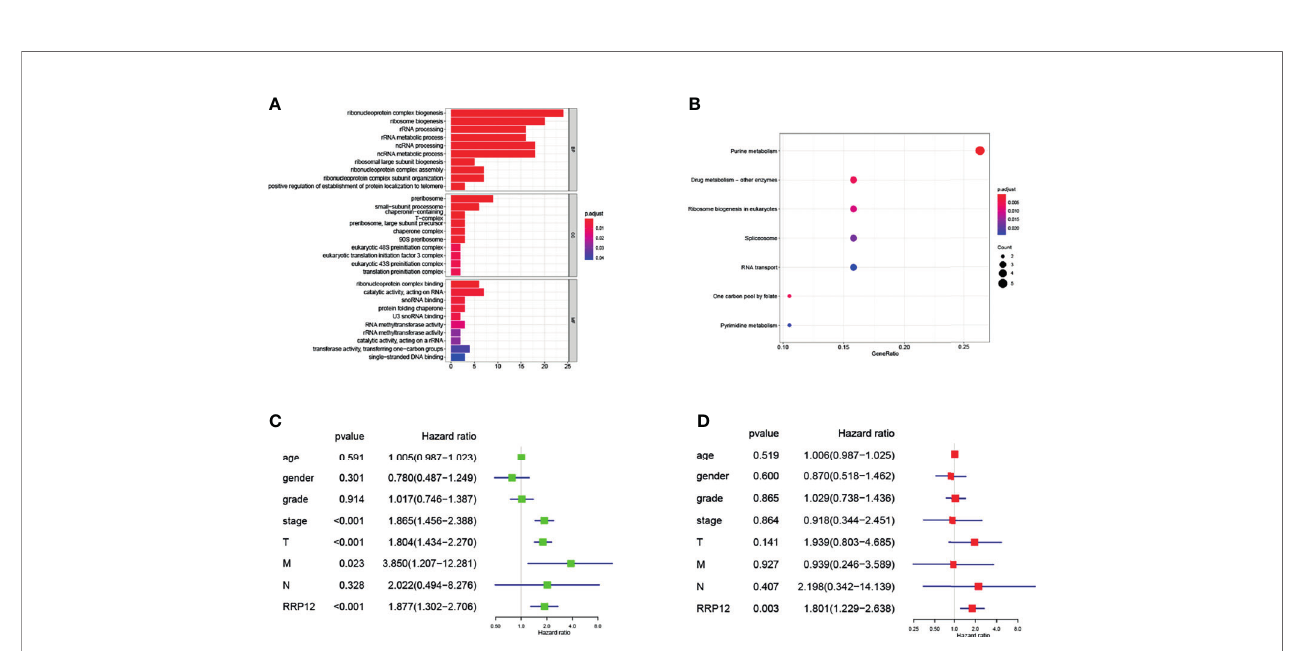
FIGURE 5 | (A, B) The 50 genes with the highest co-expression coef fi cients with RRP12 are found through the GEPIA database (PCC>0.56), and then these 51 genes are enriched by GO and KEGG through the R “ ggplot2 ” package. (C, D) It is a univariate and multivariate Cox regression analysis of the association